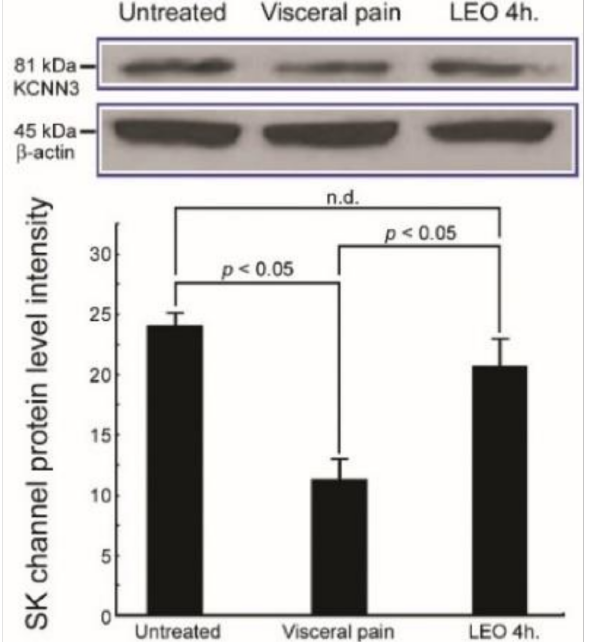
Figure 4. Immunoblots and histogram show the small-conductance calcium-activated potassium channel (SK channel) protein expression in the CeA of the untreated, visceral pain, and OS with LEO for 4h groups. Note that the protein level of the SK channel in the CeA was drastically decreased in response to visceral pain. However, in rats subjected to visceral pain and who received LEO inhalation, significant increase of the SK channel protein level was clearly detected in the CeA. Also note the results of anti- β -actin, which demonstrate the equal loading of proteins. n.d. = no significant